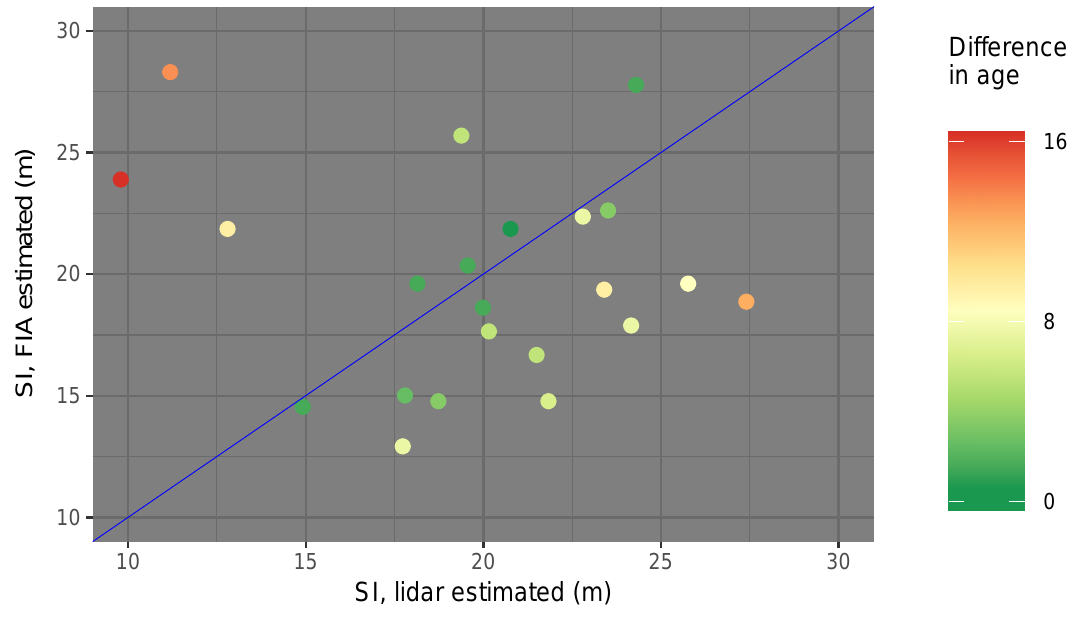
Figure 11. Correspondence between site index predictions from ALS and estimates from FIA for 19 planted pine plots. The absolute difference in age (years) predicted by eVCT and estimated by FIA is also indicated. The 1:1 line is shown in